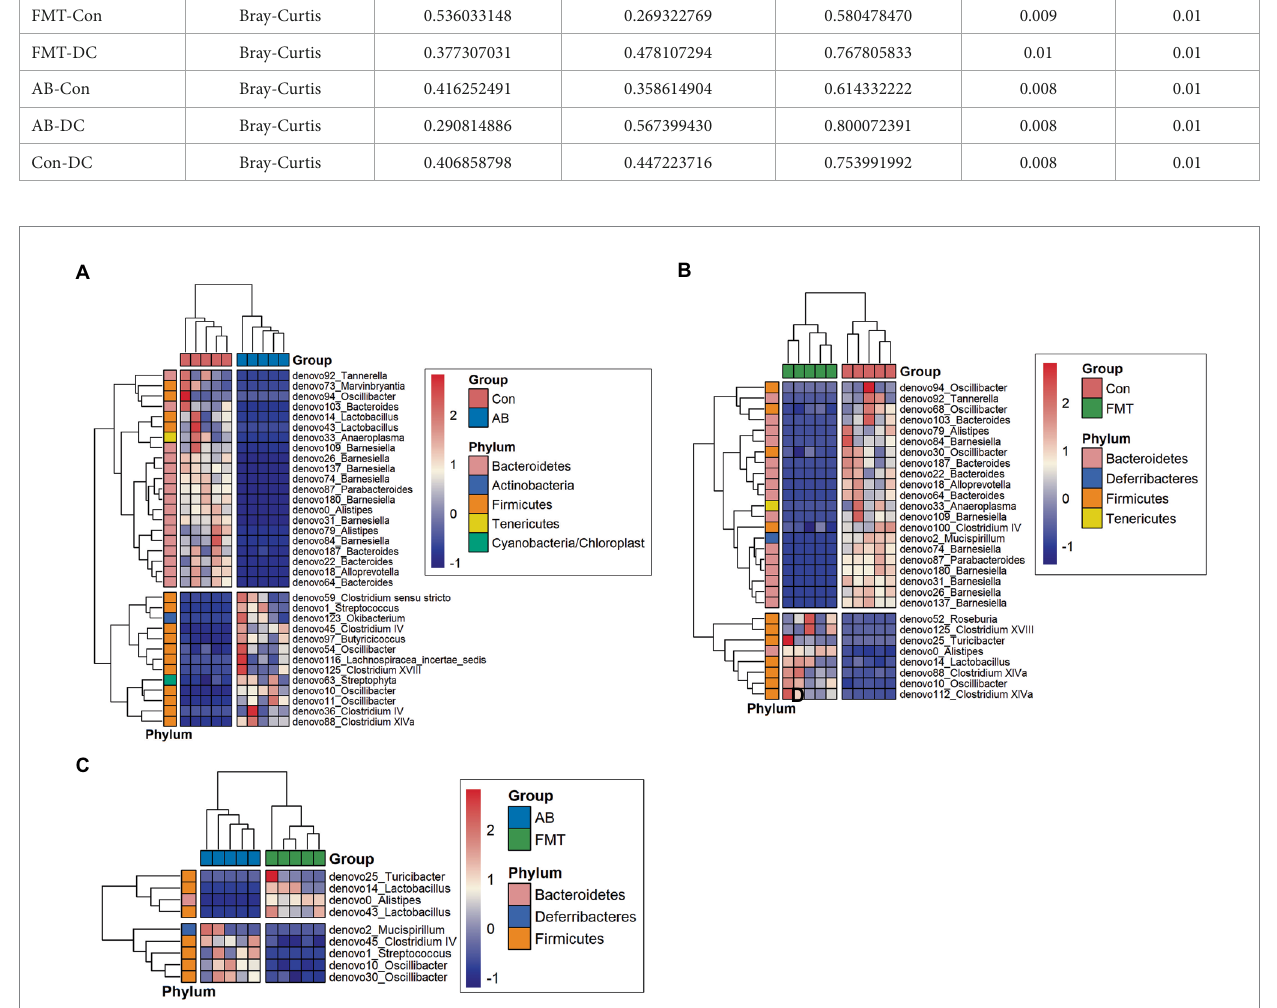
FIGURE 8 Heatmap of differential species abundance clustering between Con and AB groups (A) , Con and FMT groups (B) , and AB and FMT groups (C) . The heatmap shows the hierarchical clustering of samples based on the relative abundance of fecal microbiota in the FMT, AB and Con groups. The relative values in the heatmap (after normalization), depicted by color, indicate the degree of aggregation or content of bacterial species among samples at the genus level. The color gradient from blue to red indicates low to high relative abundance, respectively. The vertical clustering indicates the similarity in the richness of different species among different samples. The closer the distance between two species, the shorter the branch length, indicating greater similarity in richness between the two species. Horizontal clustering indicates the similarity of species richness in different samples. Similarly, the closer the distance between two samples, the shorter the branch length, indicating greater similarity in richness of species between the two samples. Con, Control group; FMT, fecal microbiota transplantation group; AB, antibiotic